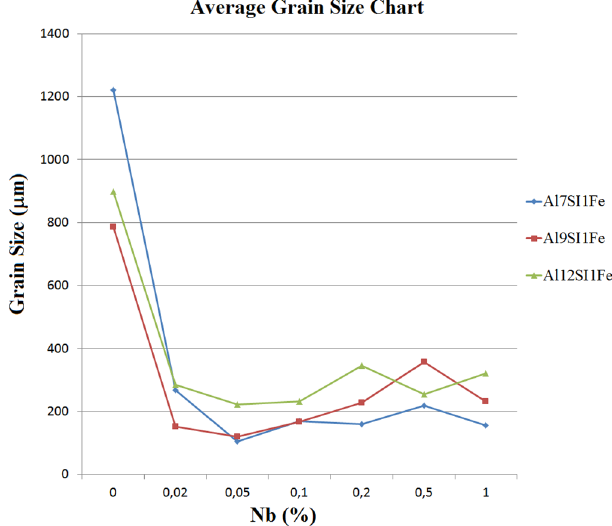
Figure 12. Average Grain Size according to Nb wt% (Microsoft Excel 2010).